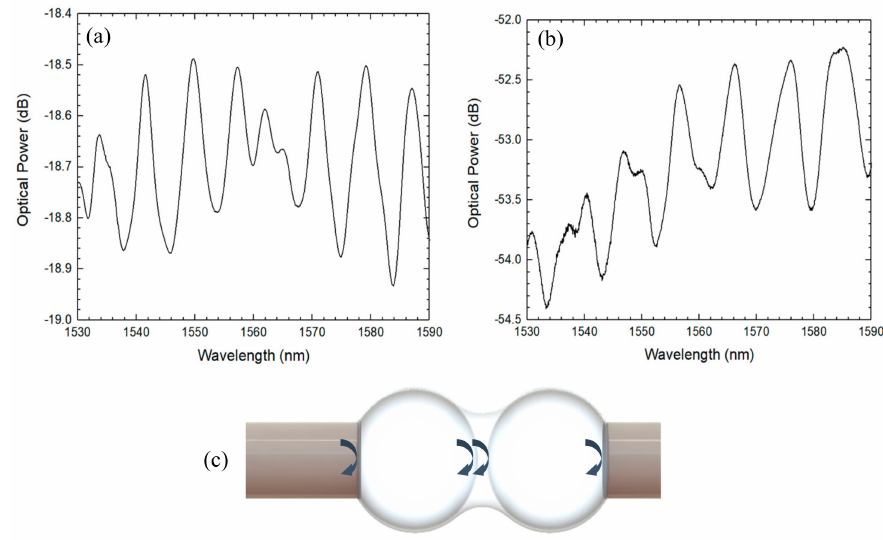
Figure 10. ( a , b ) Reflection spectrum of the two studied sensors and ( c ) schematic diagram of the two-coupled hollow microspheres.